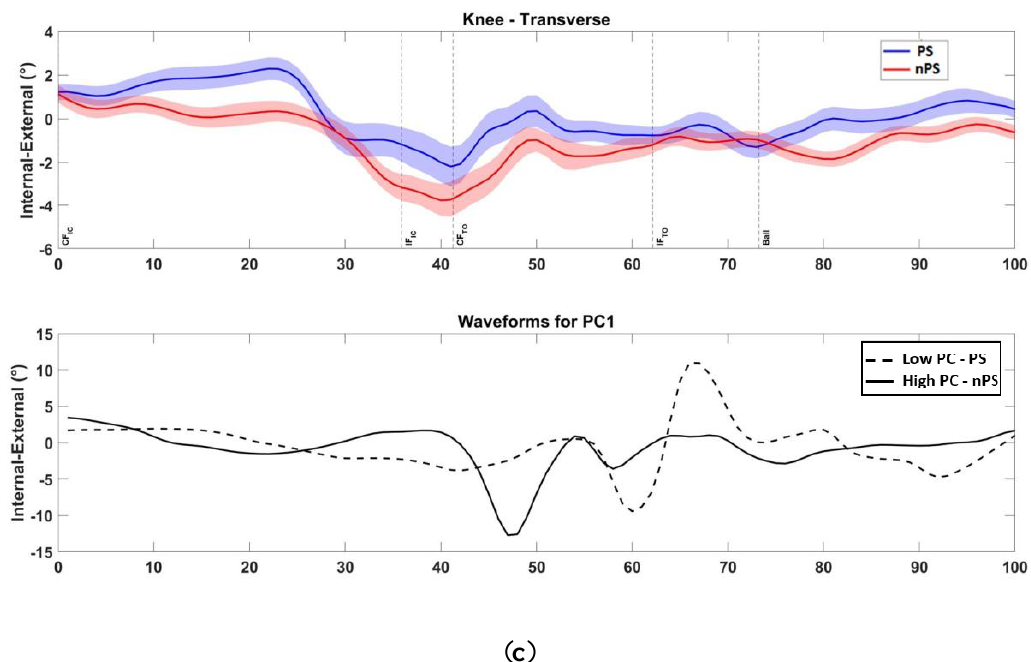
Figure A1. HIGH DIVE — Lower Limb, Contralateral : ( a ) in the bottom row, preferred side waveform is represented by the high PC (solid line) for this kinematic variable; ( b ) in the bottom row, preferred side waveform is represented by the high PC (solid line) for this kinematic variable; ( c ) in the bottom row, preferred side waveform is represented by the low PC (dashed line) for this kinematic variable. Note: PS = preferred diving side; nPS = non-preferred diving side; PC = principal component; IC = initial contact; TO = toe-off, CF = contralateral foot; IF = ipsilateral foot; Ball = ball contact.